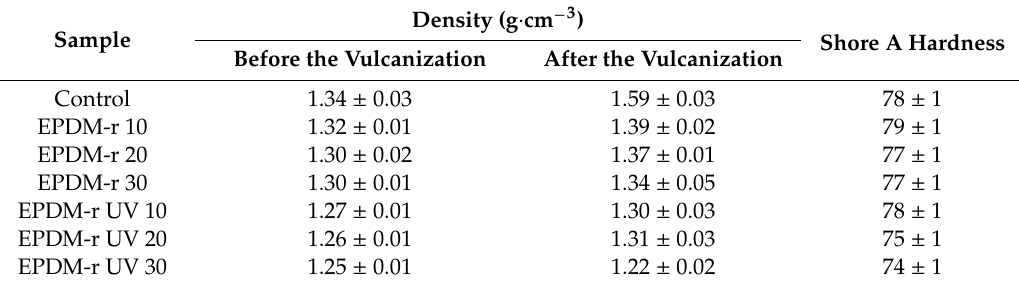
Table 5. Hardness and density values of the analyzed